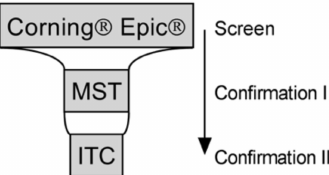
Figure 1. Summary of the screening strategy. Compounds are screened against full-length human apolipoprotein E4 (ApoE4) using Corning Epic and tested by microscale thermophoresis (MST) and isothermal titration calorimetry (ITC). Binding of confirmed hits were then evaluated by ITC against human full-length ApoE2 and ApoE3 to determine